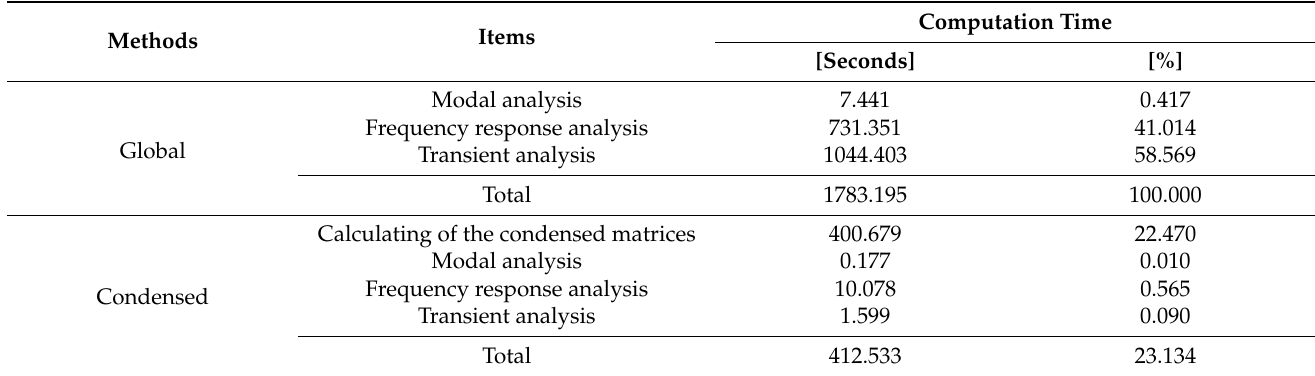
Figure 13. Computation time breakdown for structural dynamic analysis of stiffened plate. Table 5. Computation time for each item for structural dynamic analysis of stiffened plate.